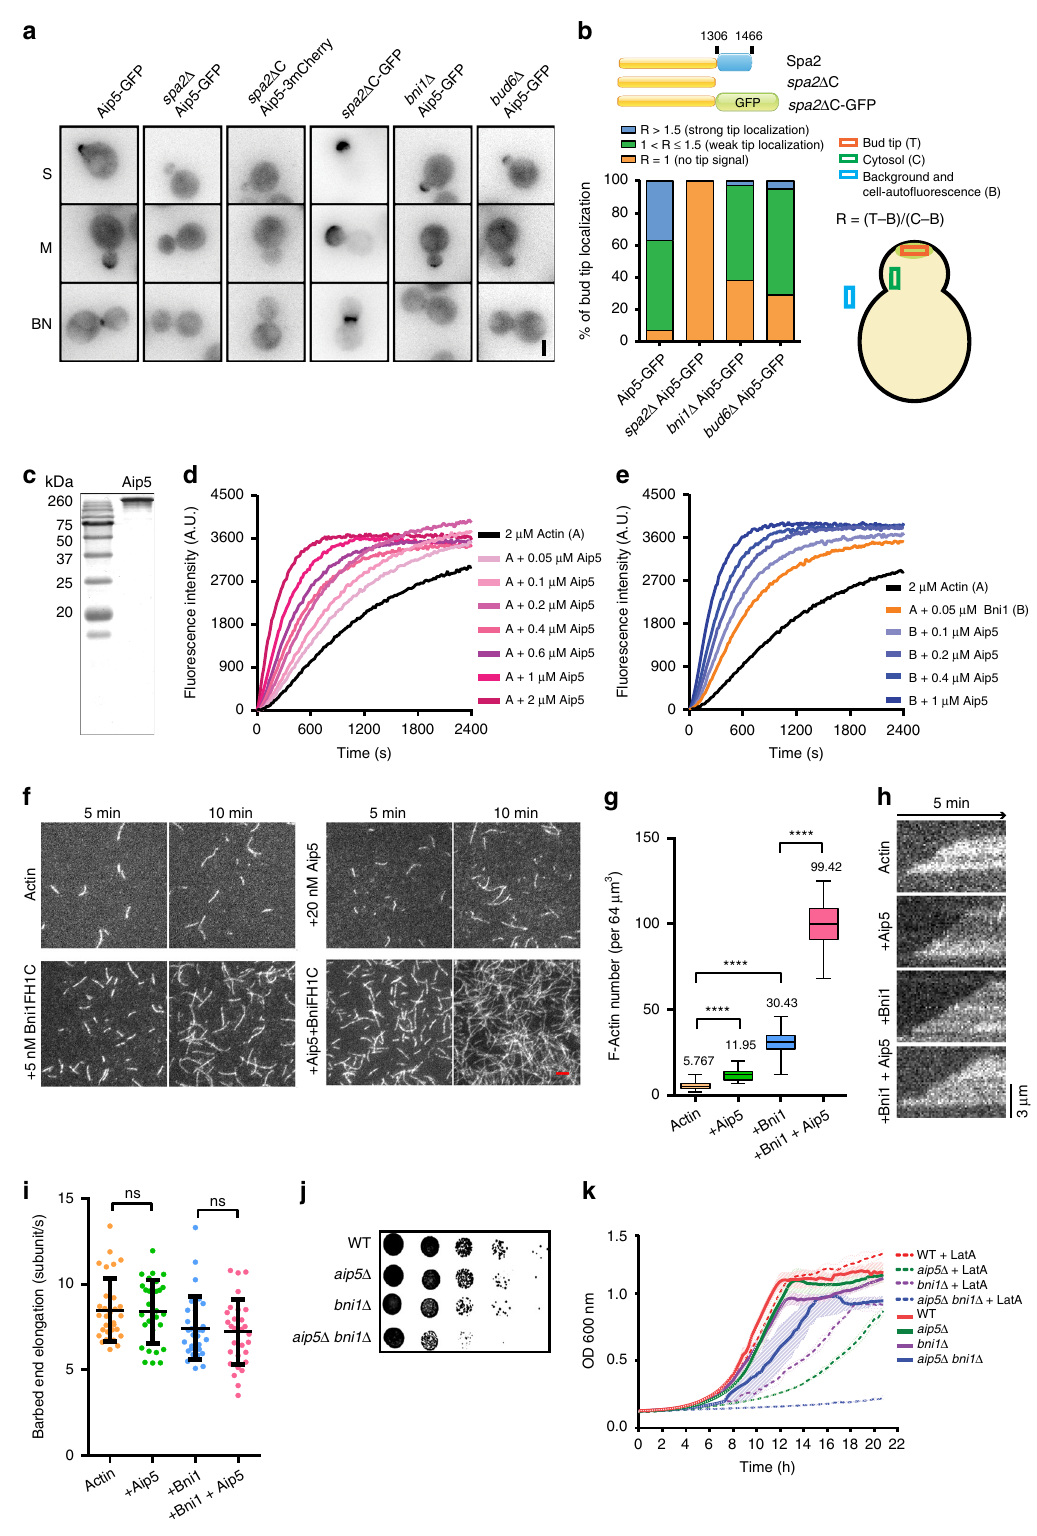
Aip5 C-terminus promotes Bni1-mediated actin assembly .